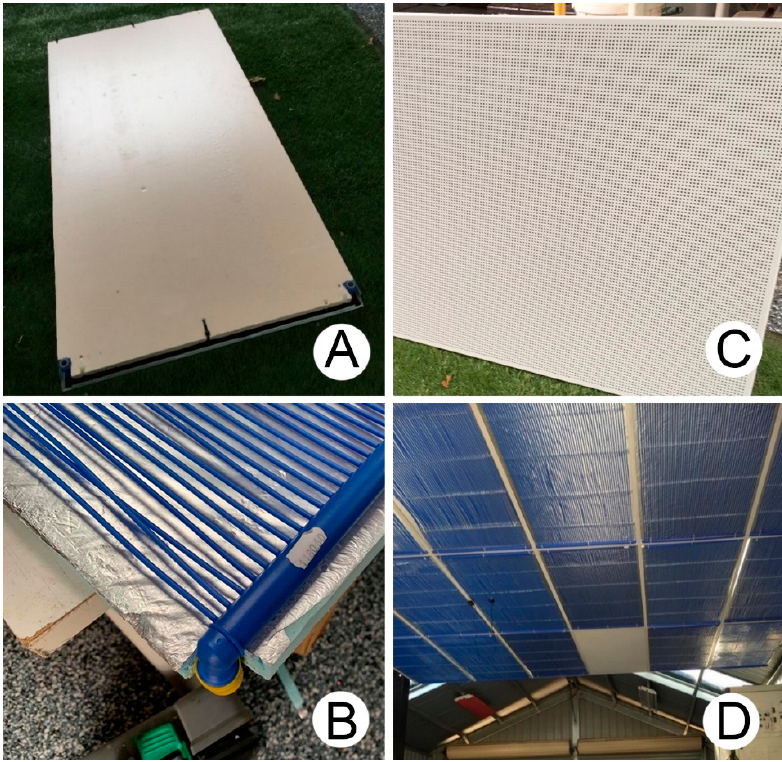
Figure 11. Capillary radiant panel system prototype: ( A ) Insulation board at the back; ( B ) Aluminium foil in contact with tube mat; ( C ) Perforated metal sheet at the front; ( D ) integrated into a ceiling panel. Source: First and second authors.